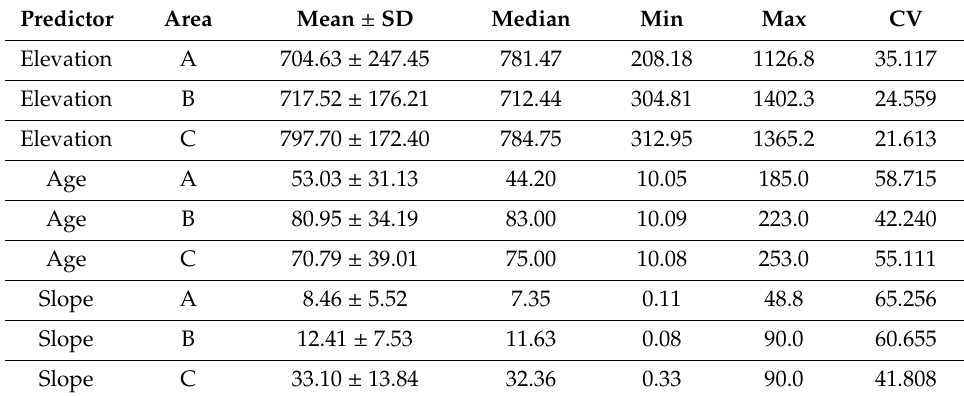
Table 4. Summarized statistics of predictors elevation, age and slope for sites A, B and C. SD means standard deviation and CV coe ffi cient of